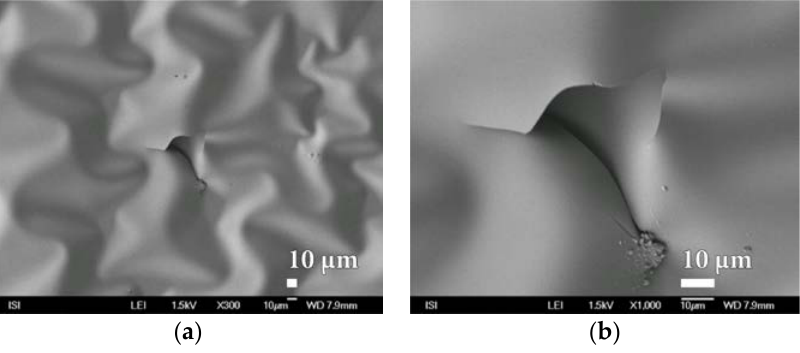
Figure 14. SEM micrographs of surface SiO x barrier nanocoating prepared by plasma deposition by HMDSO on the silicon wafer at magnification of ( a ) 300× and ( b ) 1000×.